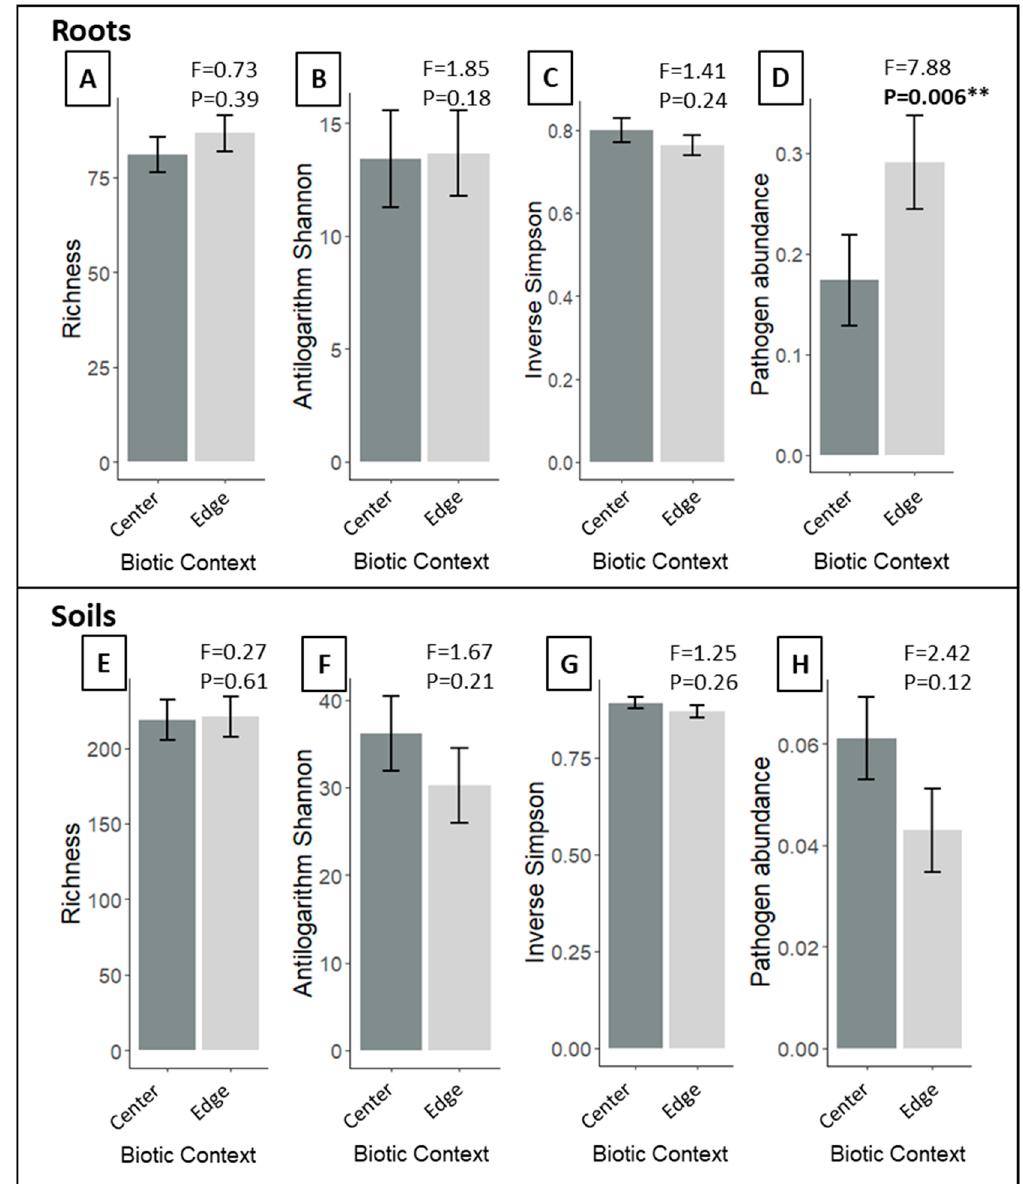
Figure 3. Fungal richness, antilogarithm of Shannon’s entropy index, inverse of Simpson’s concentration index, and total putative plant pathogen abundance in center (dark grey) and edge (light grey) biotic contexts within Phragmites australis monocultures. ( A – D ) display estimated marginal means and standard errors of root fungal endosphere responses to biotic context. ( E – H ) show estimated marginal means and standard errors of soil fungal community responses to biotic context. P -values less than 0.1 are highlighted in bold and labeled with the following notation: † p < 0.1, * p < 0.05, ** p < 0.01, *** p < 0.001.